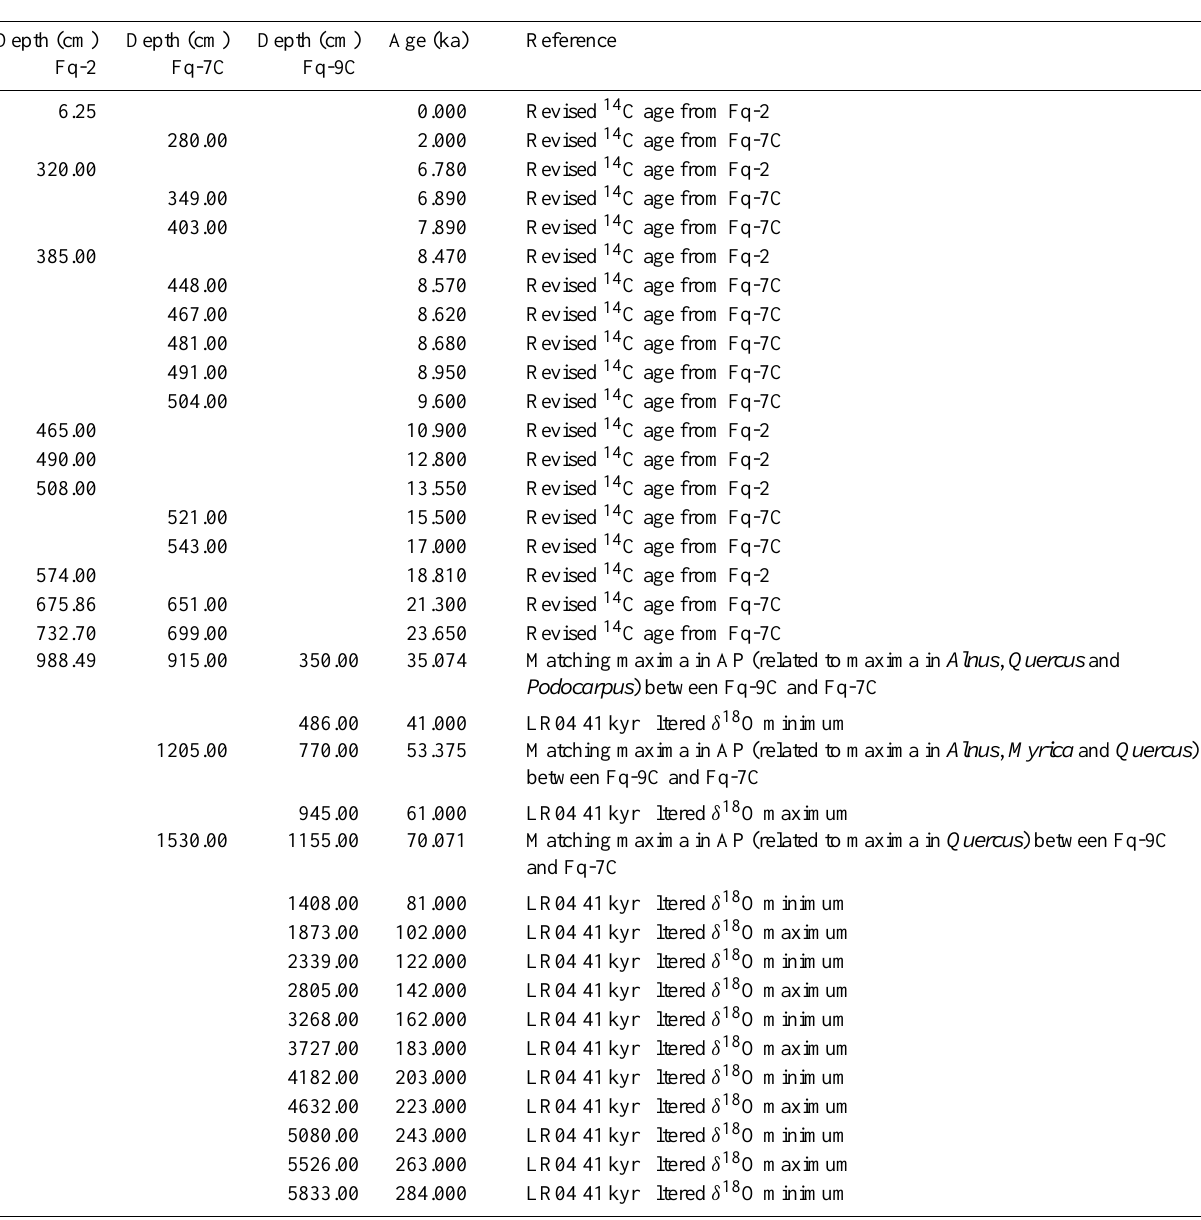
Table 1. Tie and age control points of Fq-2, Fq-7C and Fq-9C. Depth